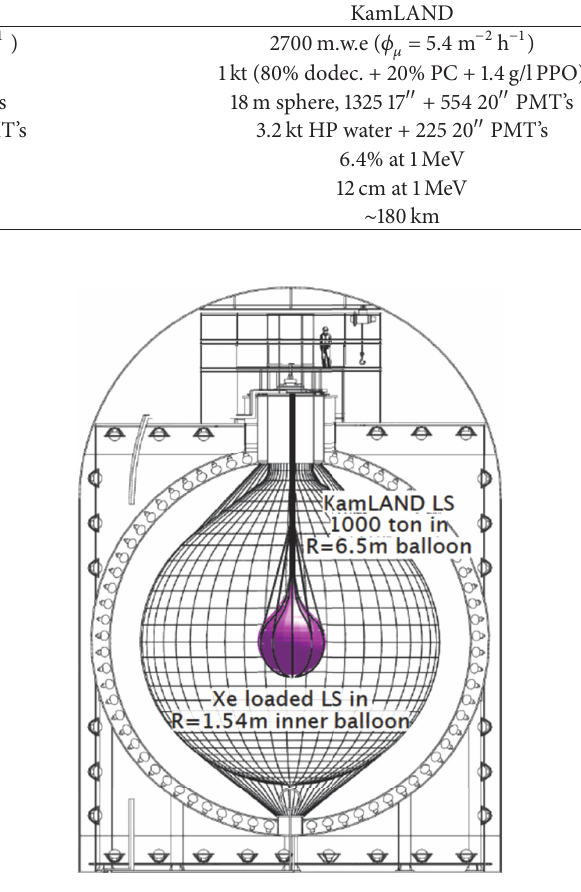
Figure 3: Schematic view of the KamLAND